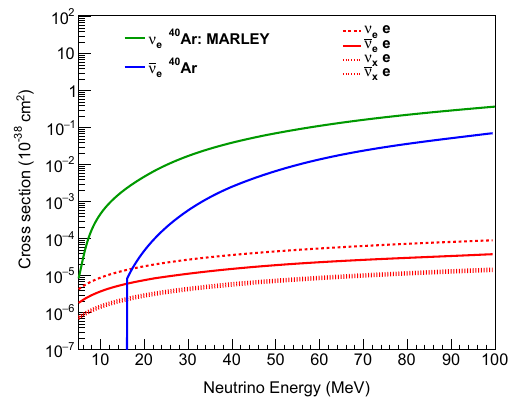
Fig. 3 Cross sections for supernova-relevant interactions in argon [6, 84] as a function of neutrino energy. The ν e CC cross section shown in green (used for the studies here) is from MARLEY (see Sect. 5.2.1.) Inelastic NC cross sections have large uncertainties and are not